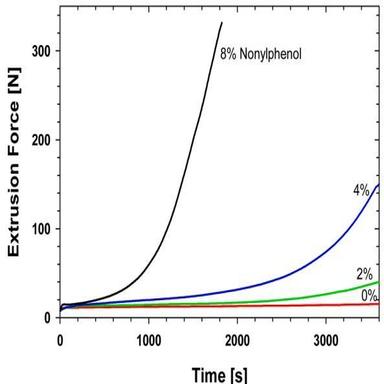
Extrusion force as a function of time during DIW printing of a reactive epoxy-amine system with various concentrations of nonylphenol (marked in the figure). The print of the 8% nonylphenol ink was aborted at 1900 s to avoid exceeding the capacity of the load transducer.